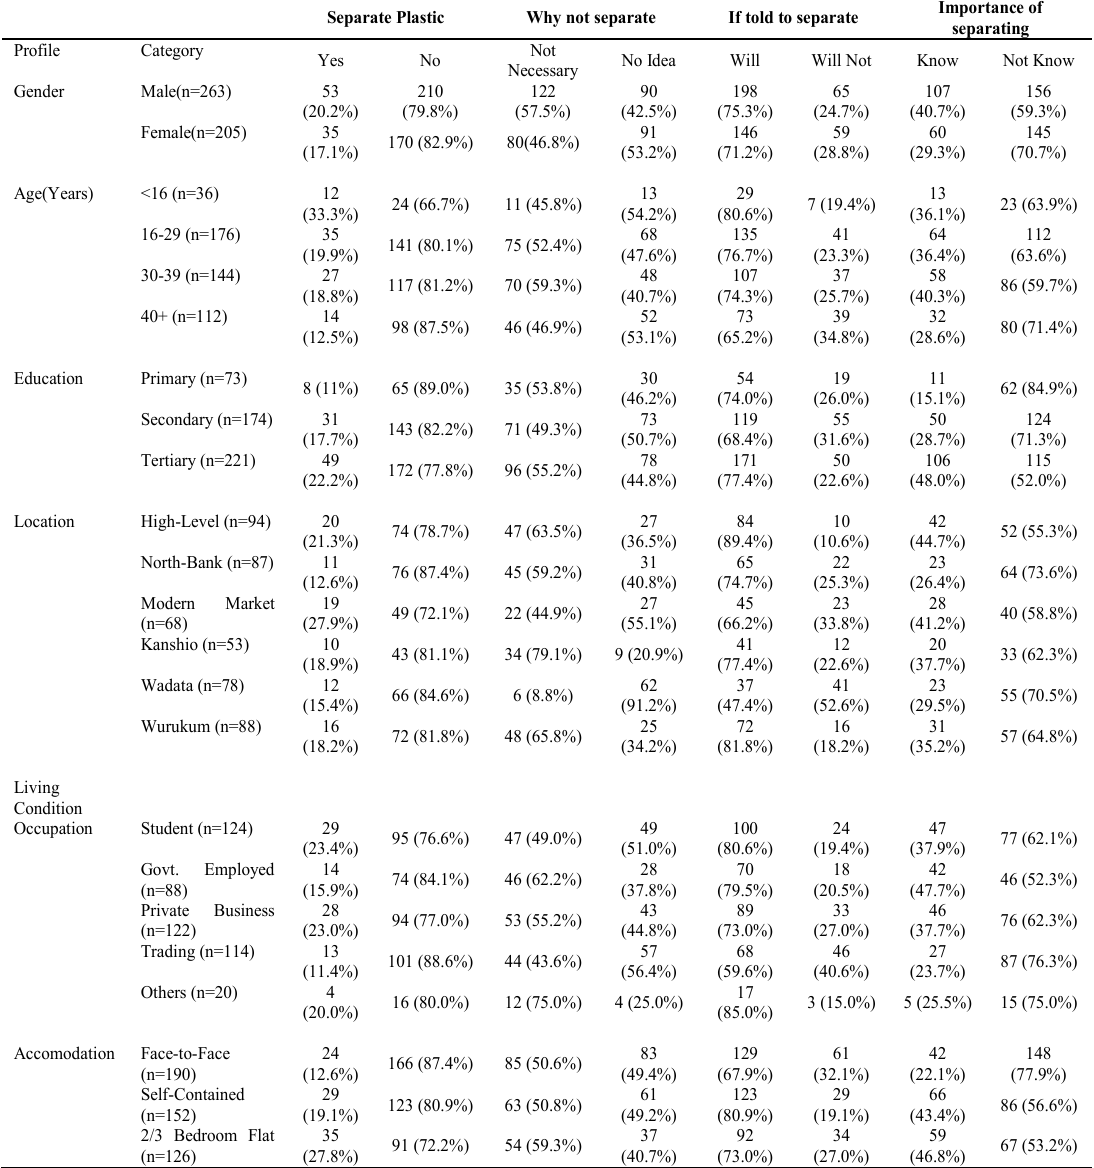
Table 4: Plastic wastes separation